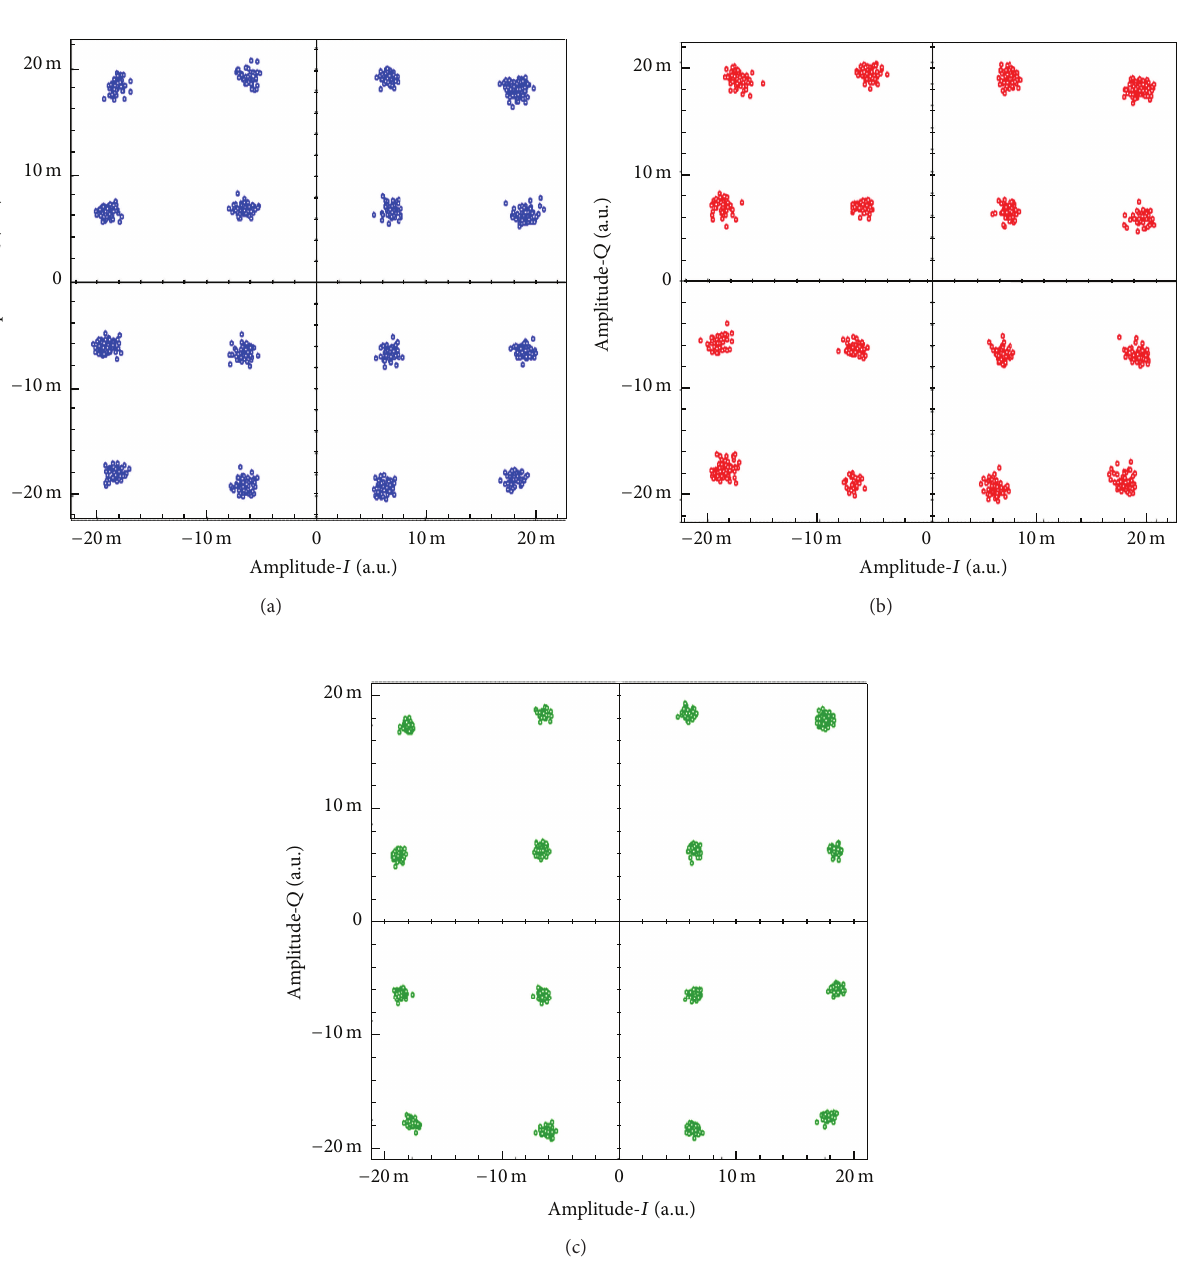
Figure 9: Constellation diagrams of the demodulated 16-QAM MIMO signals (a) MIMO 1 , (b) MIMO 2 , and (c) MIMO 3